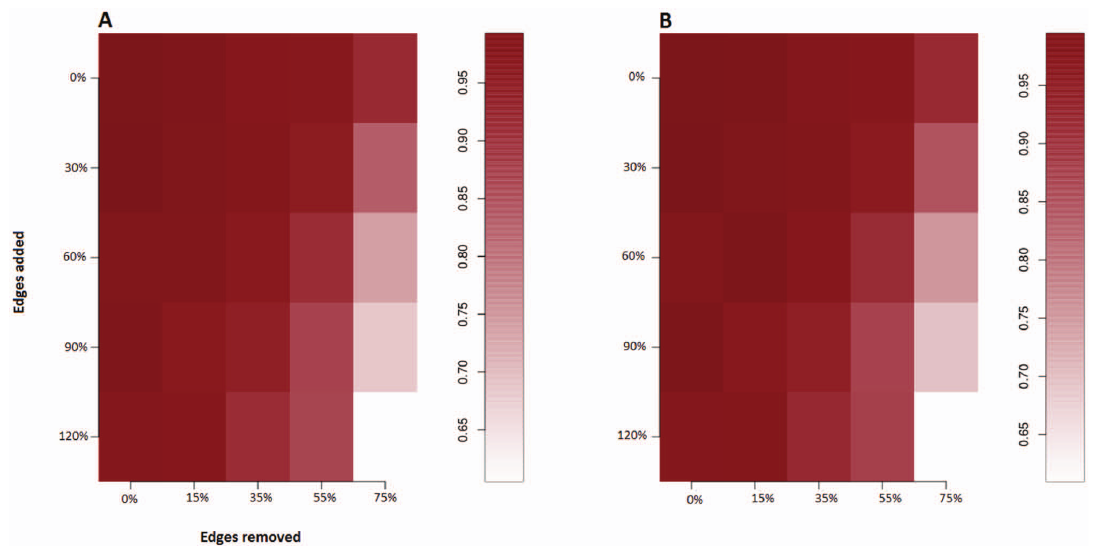
Figure 2. Robustness to network noise. (A) Sensitivity and (B) precision of the method in predicting the gene-expression-driving miRNAs when we varying the proportions of incorrect edges and missing edges in the miRNA-Gene interactions network (delete edges/insert new edges). All miRNA were also predicted to have the correct direction of influence (suppressor vs oncogene effect).